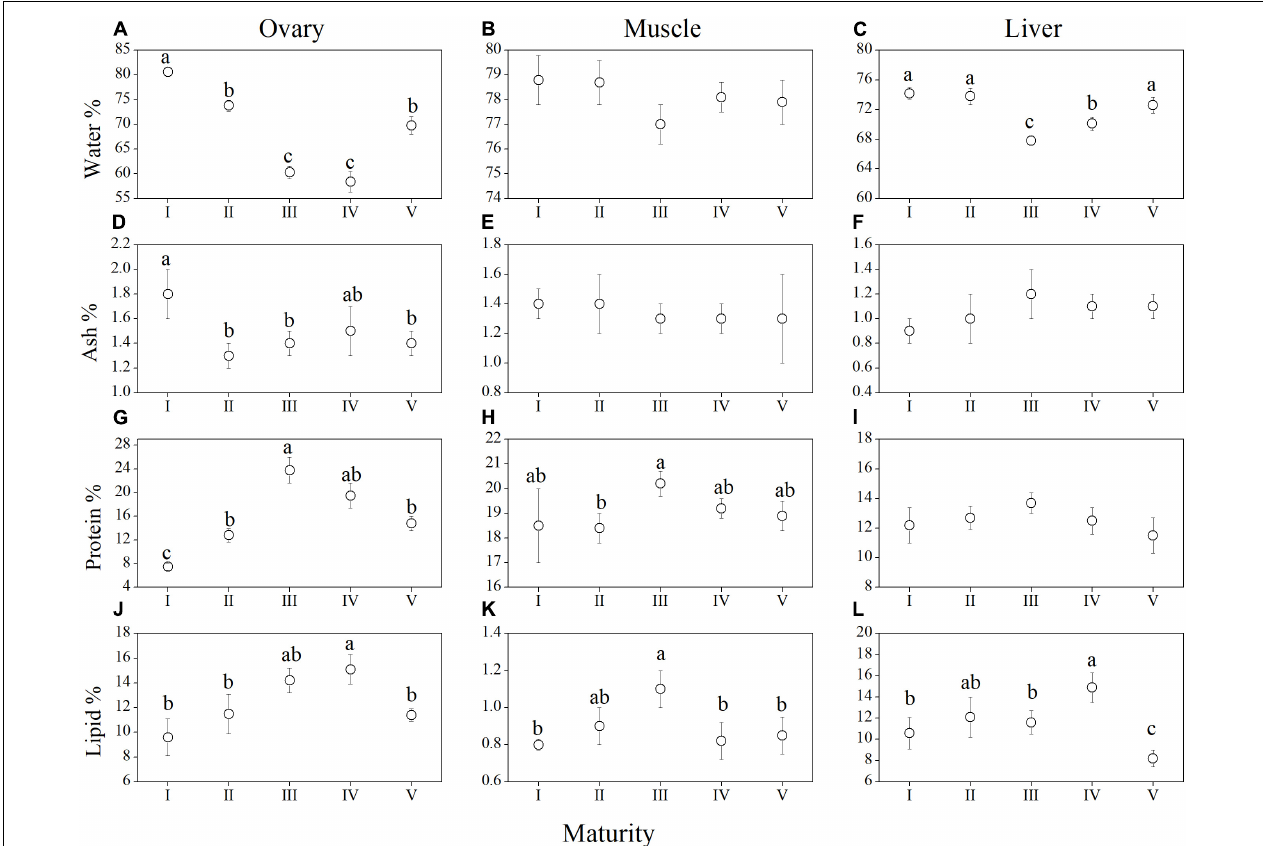
FIGURE 5 | Four main biochemical constituent proportion of different tissues in female Megalobrama terminalis from maturity stages I to V. Water content in the ovary (A) , in the muscle (B) , and in the liver (C) ; ash content in the ovary (D) , in the muscle (E) , and in the liver (F) ; protein content in the ovary (G) , in the muscle (H) , and in the liver (I) ; lipid content in the ovary (J) , in the muscle (K) , and in the liver (L) . Different superscript letters indicate significant differences of component in different maturity stage, p < 0.05.